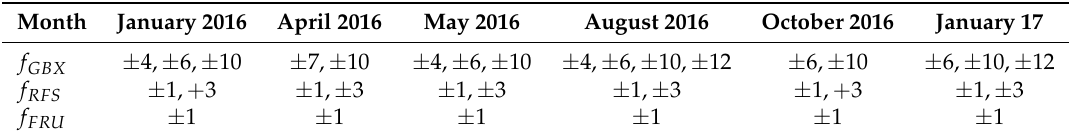
Table 3. Fault-related frequency harmonics found on the current spectra from January 2016 to January 2017 with DFIG at super-synchronous